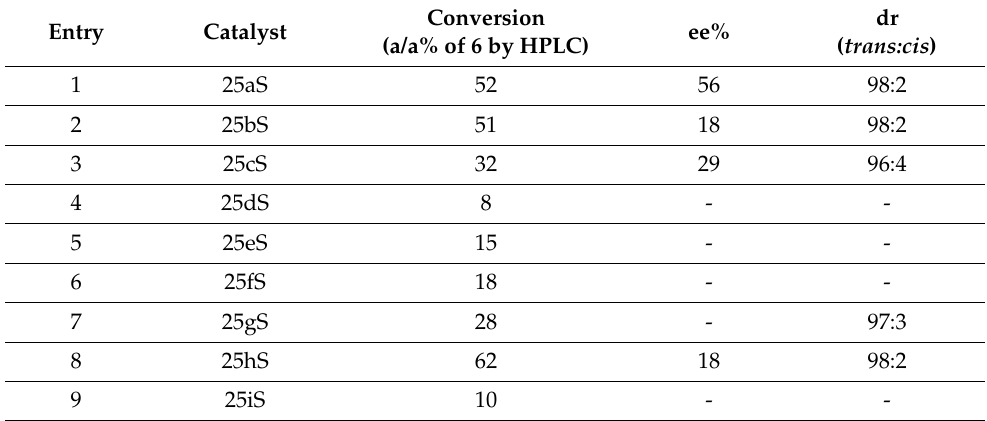
Table 2. Screening the performance of benzimidazole-thiourea catalysts in the Pinder reaction.